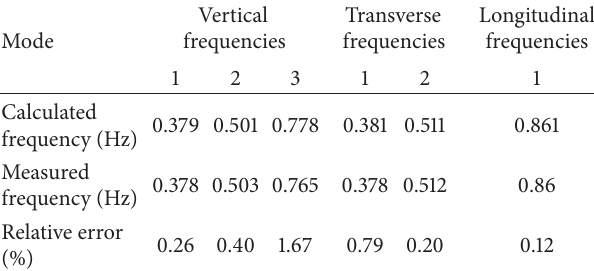
Table 16: Comparison of average values of each modal